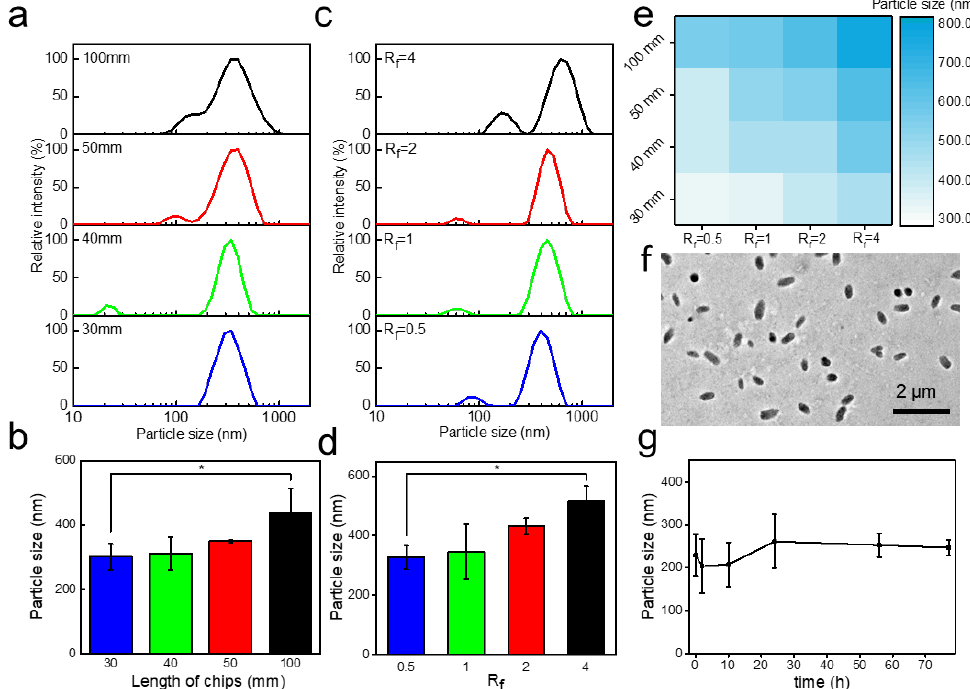
Figure 4. 3D-printed concentration-controlled microfluidic chip-based fabrication of CaA microgels. ( a ) Hydrodynamic sizes intensity distribution of CaA microgels with di ff erent channel lengths measured by DLS. ( b ) Hydrodynamic particle sizes of CaA microgels with channel lengths measured by DLS. Data are shown as mean ± SEM, n = 3, * p < 0.05, ** p < 0.01, *** p < 0.001. ( c ) Hydrodynamic sizes intensity distribution of CaA microgels with di ff erent flow rate ratio measured by DLS. ( d ) Hydrodynamic particle sizes of CaA microgels with di ff erent flow rate ratio measured by DLS. Data are shown as mean ± SEM, n = 3, * p < 0.05, ** p < 0.01, *** p < 0.001. ( e ) Hydrodynamic particle sizes of CaA microgels di ff erent channel lengths and flow rate ratios. ( f ) TEM image of CaA microgels. ( g ) The hydrodynamic particle sizes of CaA microgels measured over 77 h using DLS.